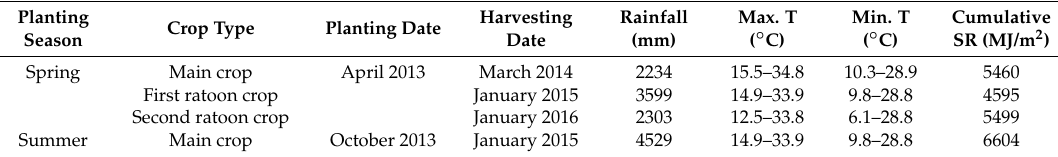
Table 1. Planting seasons and harvesting periods of sugarcane crops used to compare the performance of two irrigation methods and climatic conditions during the periods.